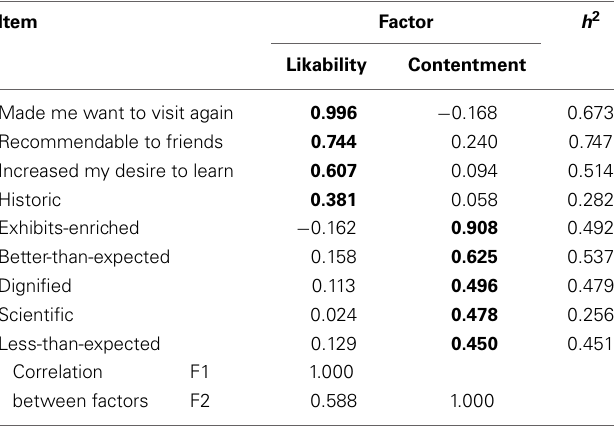
Table 1 | Factor loadings for the items in the appreciation scale after promax rotation.